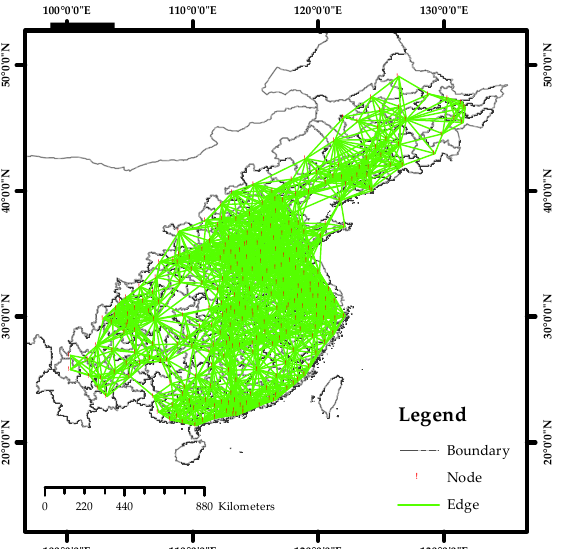
Figure 10. The composite urban network.